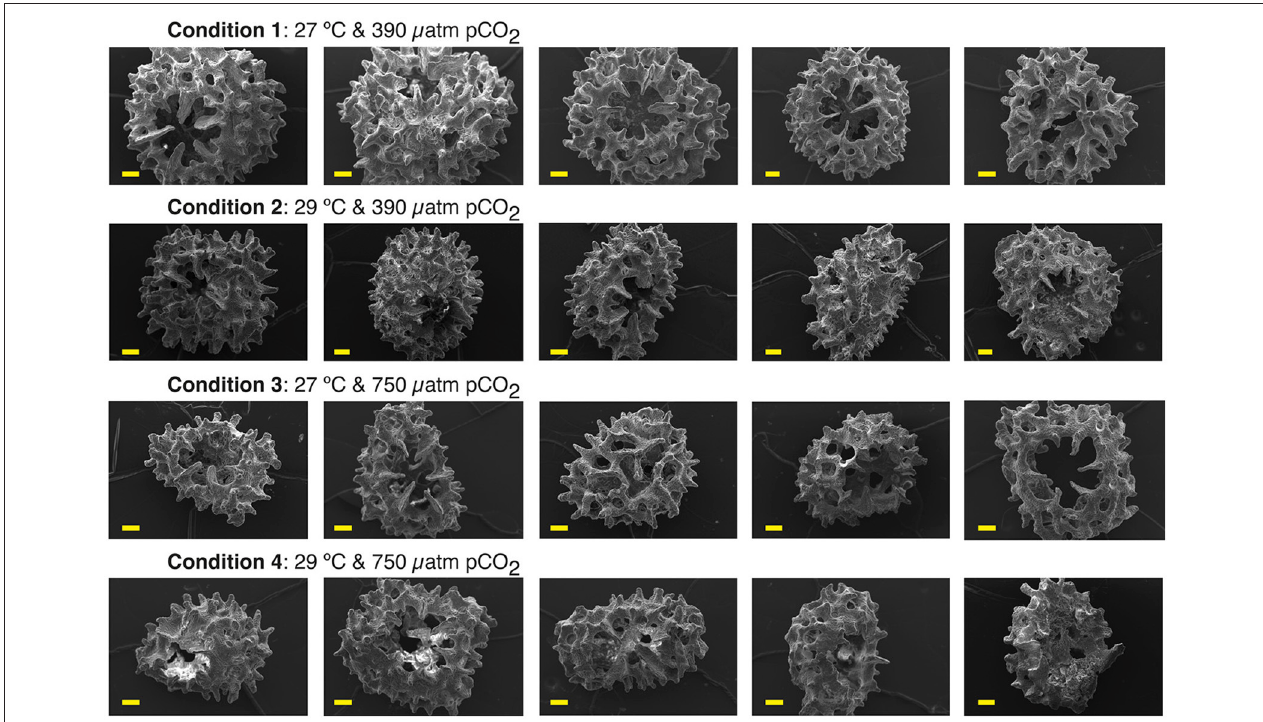
FIGURE 3 | Representative Scanning Electron Microscopy results of primary polyp A. millepora juvenile corals. Each row of images is grouped by experimental condition, which are stated above the row and shown from left to right. Each image is a distinct A. millepora primary polyp that has been analyzed by laser ablation for this study. Most A. millepora individuals are shown with oral cavity in the center of the image or placement on its side. The normal, near symmetrical morphology of the primary polyps of conditions 1 and 2 are shown in the top two rows. The asymmetrical morphology of primary polyps of conditions 3 and 4 with impacted stunted and retarded growth are shown in the bottom two rows. All scale bars are 100 µ m.